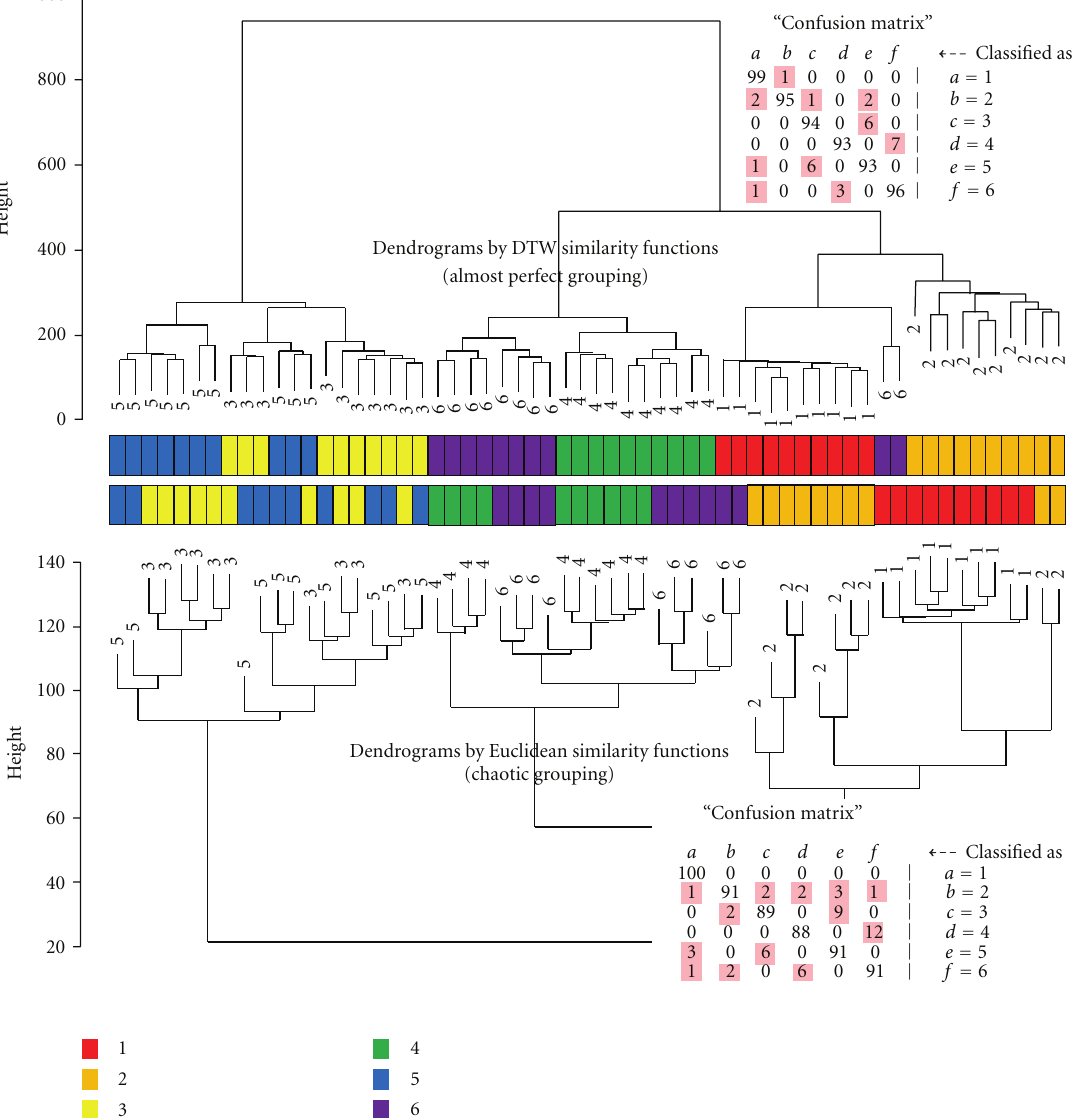
Figure 8: A bird-eye view of the comparison of the dendrograms which are produced by DTW and Euclidean similarity functions